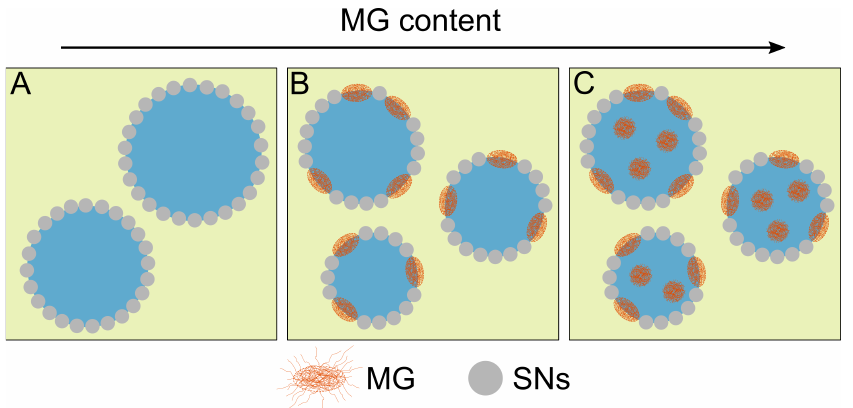
Figure 7. With increasing MG content, more MG is incorporated at the interface until saturation of the interface. ( A ) The emulsions stabilized by solid particles only show a tight packing of SNs at the interface. ( B ) The SN coverage is reduced with increasing amount of present MGs. ( C ) This incorporation is limited to a minimum SN coverage of around 0.56. Introducing more MG into the system only results in more MG situated in the bulk phase of the water